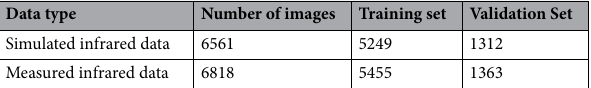
Table 3. Division of training connection and verification set in data